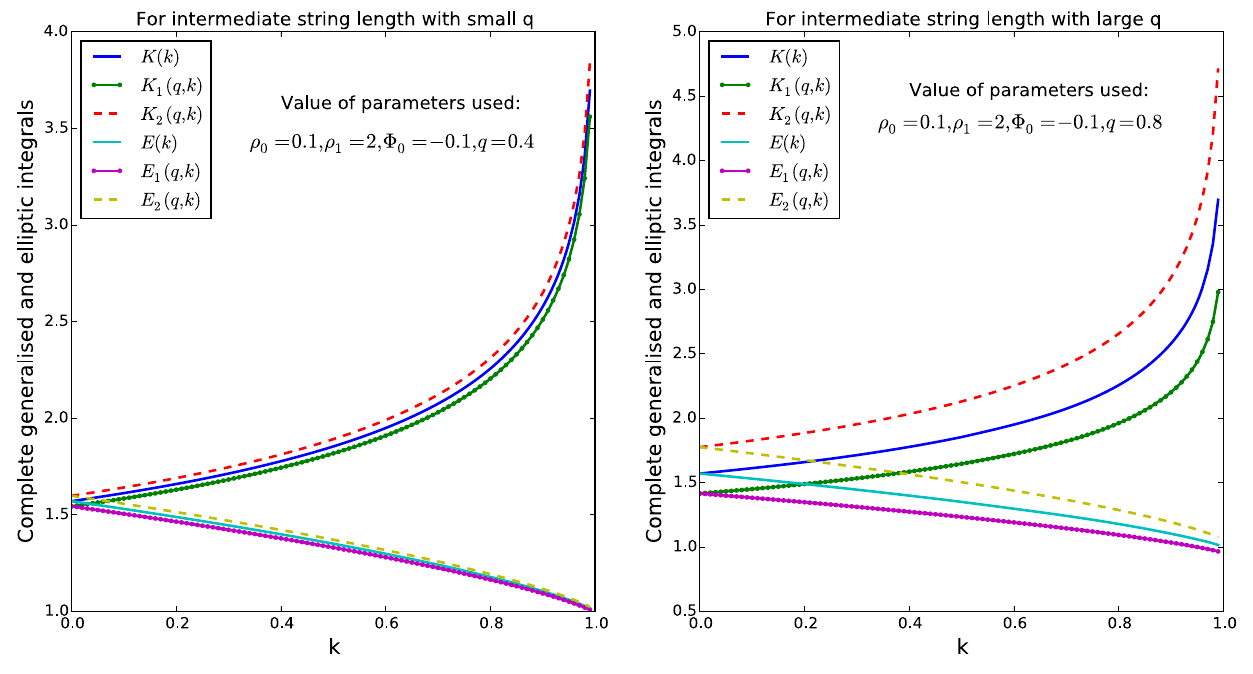
Fig. 3 Complete generalised integrals K 1 ( q , k ) , K 2 ( q , k ) , E 1 ( q , k ) and E 2 ( q , k ) has been plotted alongwith complete elliptic integrals of first kind K ( k ) and second kind E ( k ) for intermediate length of string with q = 0 . 4 and q = 0 . 8. It is clearly showing that the curve for K ( k )